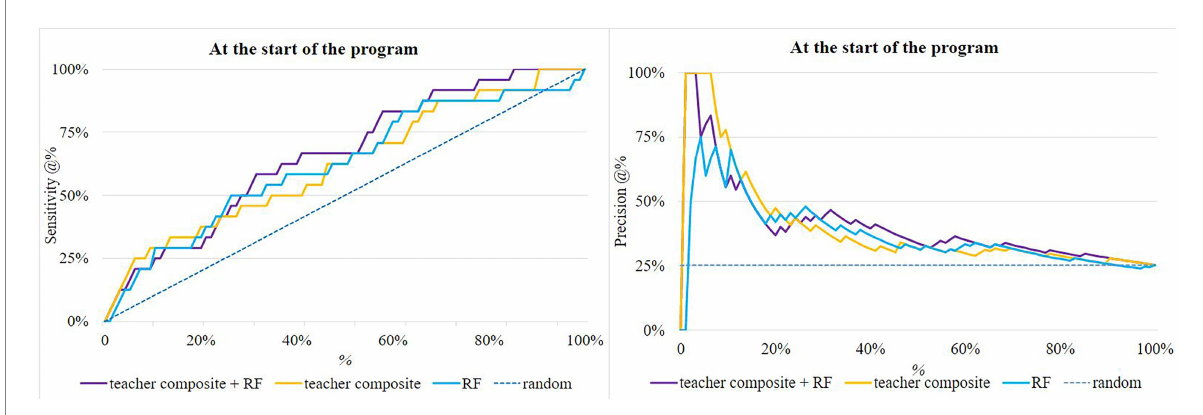
FIGURE 3 Sensitivity and Precision @% at the start of the program of the Random Forest, the teacher composite and a combination of both (“teacher composite + RF”). The dashed line represents the sensitivity of random invitation.